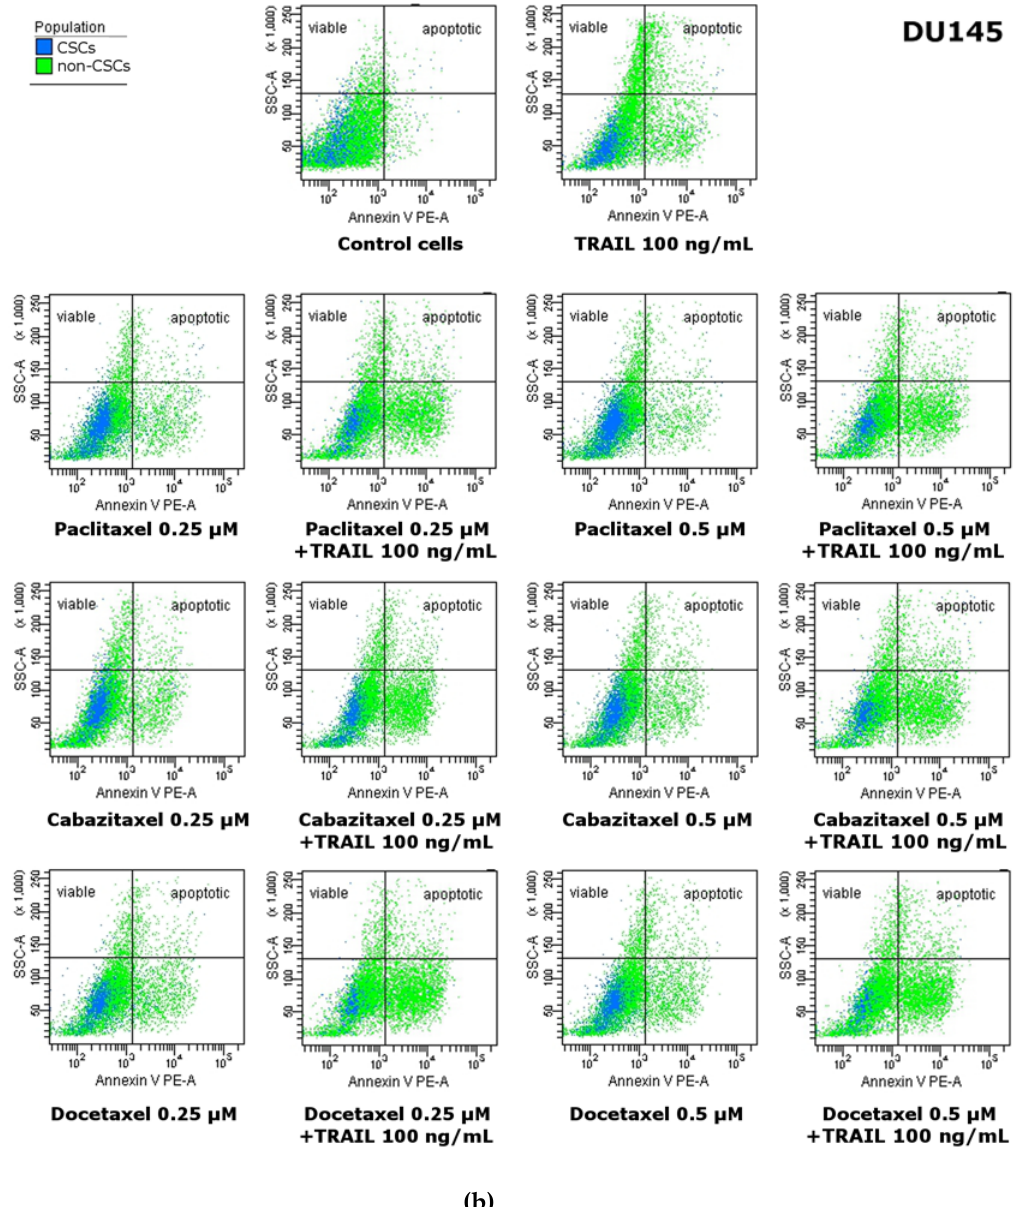
Figure 5. Apoptotic effect of TRAIL (100 ng/mL) in combination with paclitaxel, cabazitaxel and docetaxel on CSCs and non-CSCs subpopulations within: PC3 ( a ) and DU145 ( b ) prostate cancer cells. Cells were incubated with anti-CD24 FITC-labeled, anti-CD44 APC-labeled antibodies and Annexin V-PE labeled. CSCs marked as blue, non-CSCs marked as green. Viable cells are located on the left site of the dot plot and apoptotic cells on the right site of the dot plot.